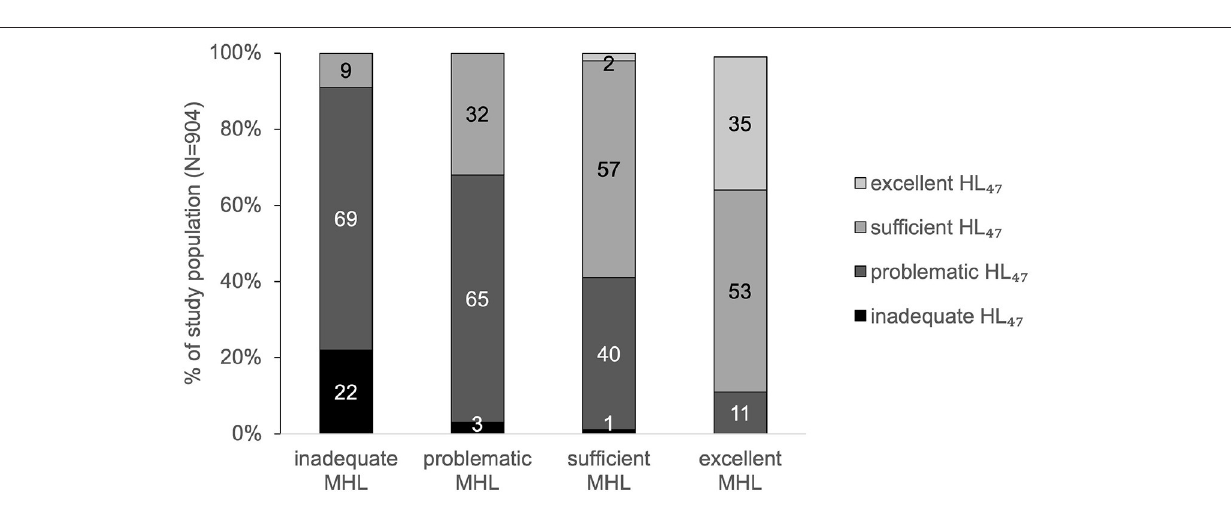
FIGURE 3 | Association of MHL and HL 47